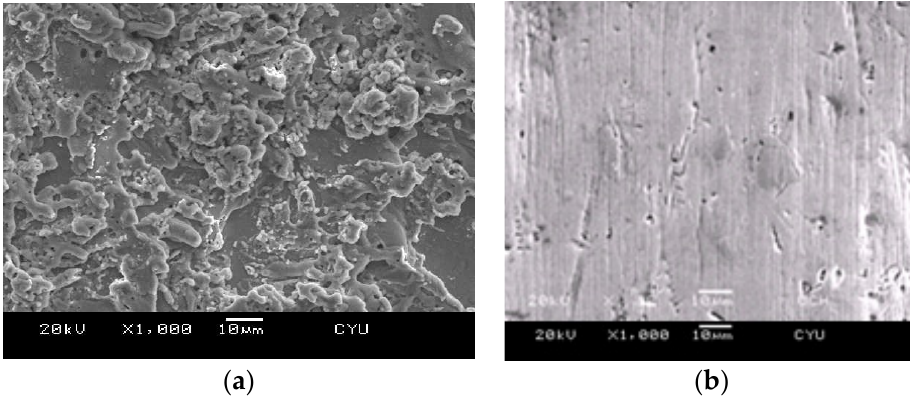
Figure 13. Thecharacteristics of SEM micrography (×1000) of the workpiece surface: ( a ) SEM photo during WEDM; ( b ) SEM photo after polishing by RDSM-AFM. during WEDM; ( b ) SEM photo after polishing by